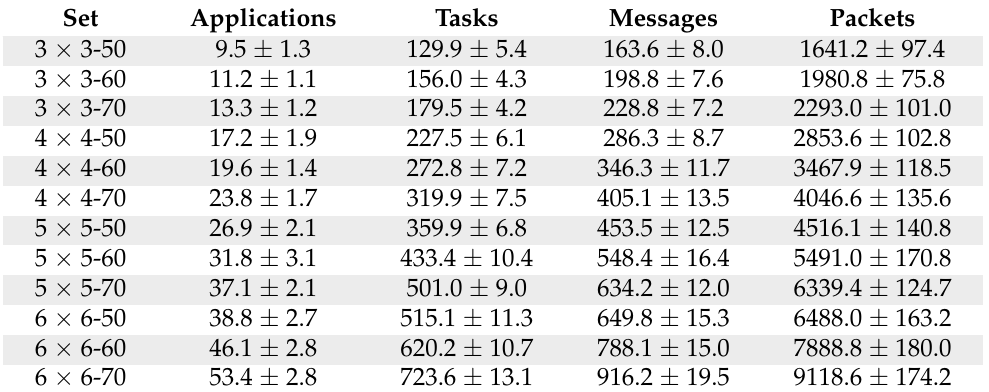
Table 1. Overview instances: average numbers with standard deviation of 25 instances per sys- tem specification. Set Applications Tasks Messages